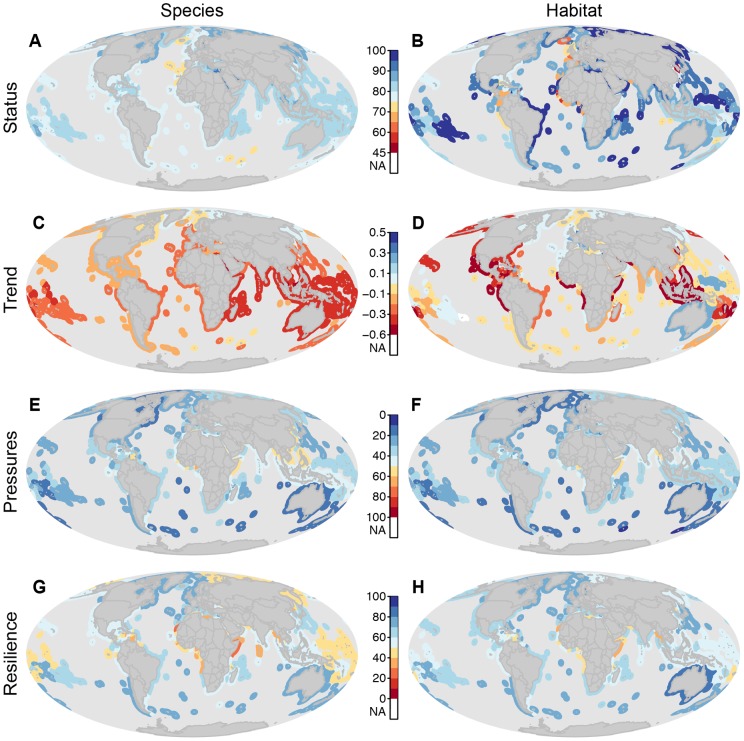
Scores for species status (A), habitat status (B), species trend (C), habitat trend (D), species pressures (E), habitat pressures (F), species resilience (G), and habitat resilience (H).Note changes in color ramps for the different panels.